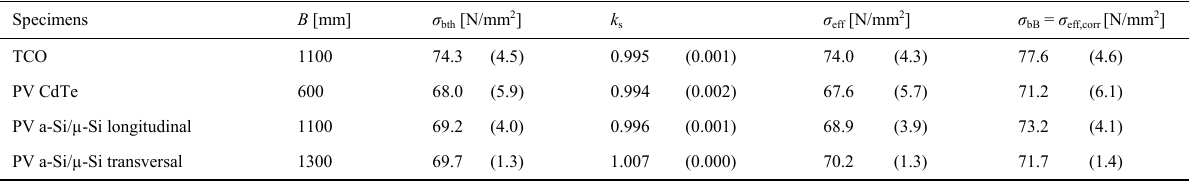
Table 6: Calculation and correction of the overall bending strength in the surface area, including the edges (mean values, standard deviation in brackets). Specimens B